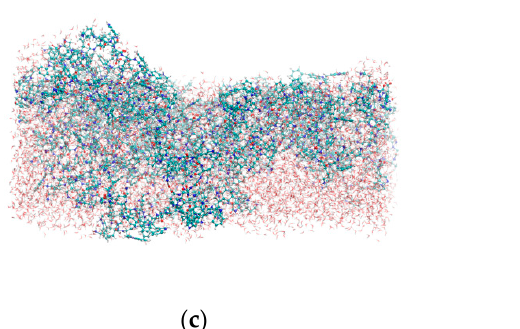
Table 3. The values of the diffusion coefficients of the peptide molecules in the water films and the surface tensions in the